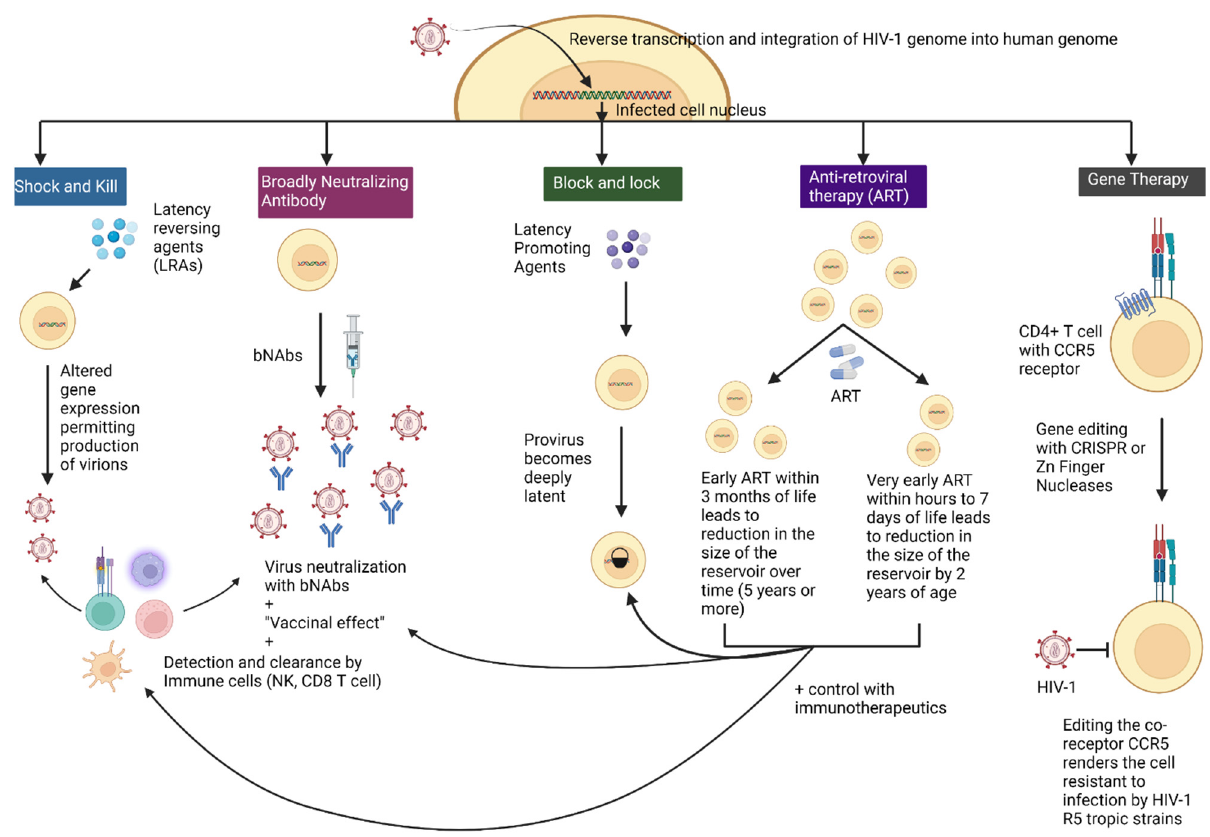
Figure 1. Various cure strategies to eradicate HIV-1 infection. Upon infecting the cell, HIV moves to the nucleus where it inserts its cDNA genome into the host genome to form the proviral reservoir. The reservoir is persistent and quiescent and poses a barrier to cure. It needs to be eradicated or